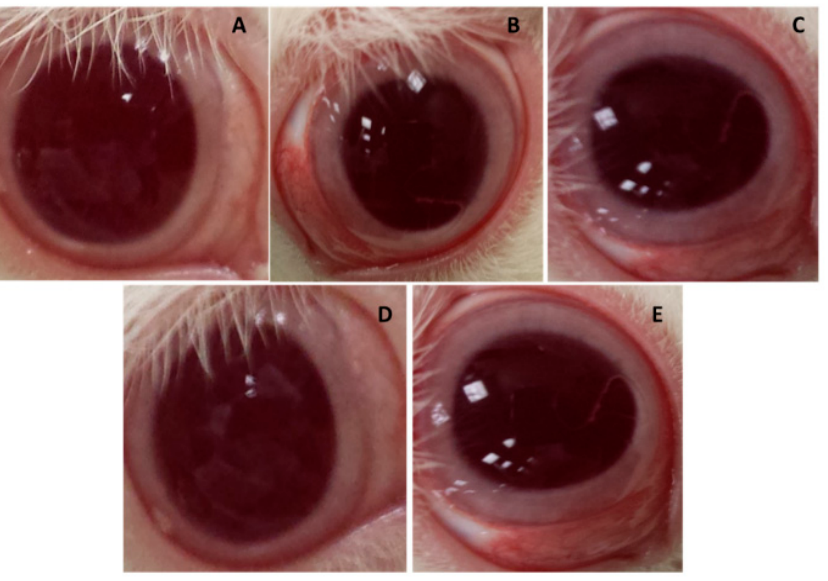
Figure 3. Ocular irritation study conducted by Alkholief et al., revealing ( A ) normal condition of rabbit eye; ( B ) mild redness and inflammation in the conjunctival area by the first hour post- administration; ( C ) increased redness and inflammation by the third hour; ( D ) reduced redness and inflammation by the sixth hour; ( E ) complete reduction of redness and inflammation by the twelfth hour, adapted with permission from [66], Elsevier, 2019.